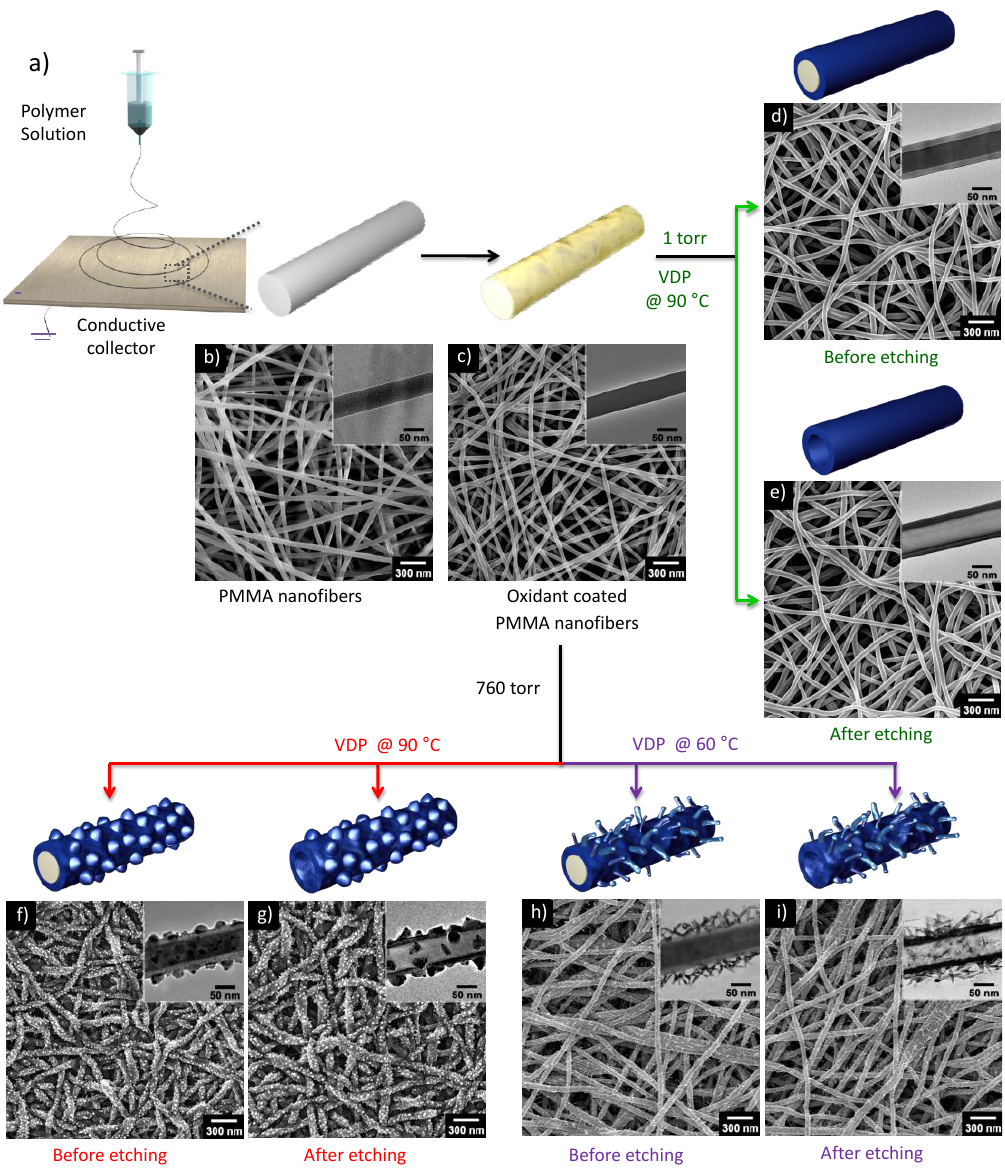
Figure 8. Multidimensional poly(3,4-ethylenedioxythiophene) (PEDOT) nanostructures with unique surface substructures. ( a ) Schematic of the synthetic routes for fabricating multidimensional PEDOT nanostructures; ( b – i ) The poly(methyl methacrylate) (PMMA) nanofibers serve as a template and substrate for the growth of PEDOT under different synthetic conditions (temperature and pressure). The morphologies of the resulting nanomaterials were characterized by SEM and TEM (right top inset images): PMMA nanofibers ( b ) before and ( c ) after ferric ion adsorption; PMMA/PEDOT nanofibers with a smooth layer surface ( d ) before and ( e ) after core etching; PMMA/PEDOT nanofibers with nanorod surface ( f ) before and ( g ) after core etching; PMMA/ PEDOT nanofibers with NN surface ( h ) before and ( i ) after core etching. With permission from [64]; Copyright 2012, American Chemical